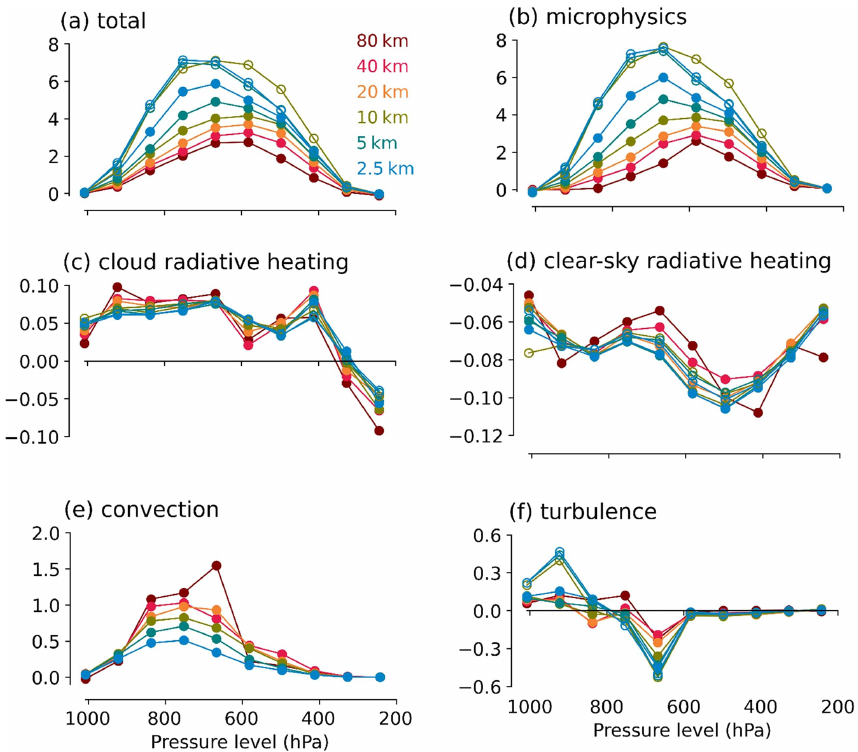
Figure 8. (a) Total diabatic heating rate (in units of Kh − 1 ) along pressure levels for different grid spacings calculated as the mean over all WCB trajectories. The lines with filled and empty markers represent simulations with parameterized and explicit convection, respectively. All simulations shown here use one-moment cloud microphysics. (b–f) Same as (a) but for heating from individual